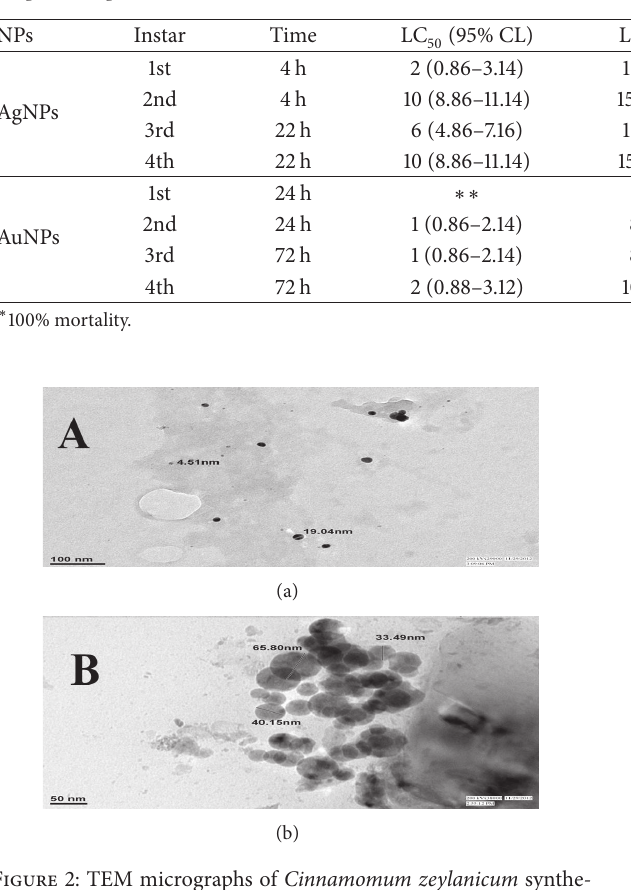
Table 1: Efficacy of silver nanoparticles and gold nanoparticles synthesized by bark extract of Cinnamomum zeylanicum against the larvae of Anopheles stephensi with their LC values, 95% confidential limits (CL), and 𝜒 2 and 𝑟 values after different time of exposure.